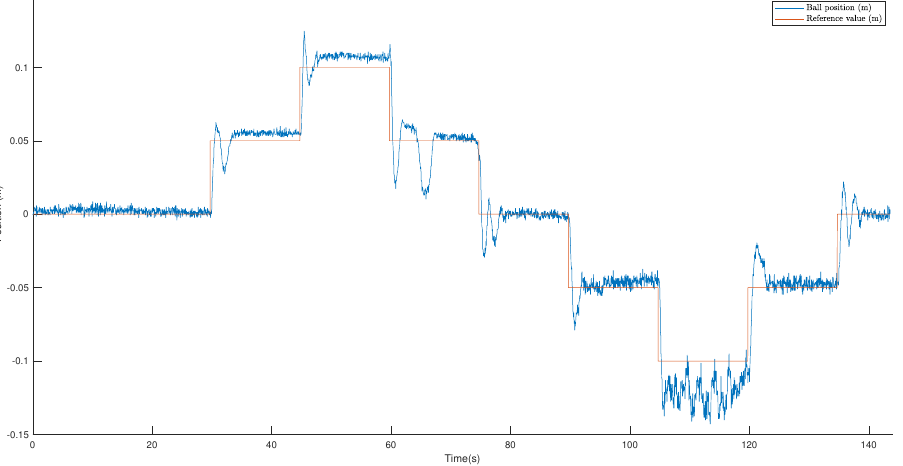
Figure 21. Position of the ball on the rail in contrast to the desired reference